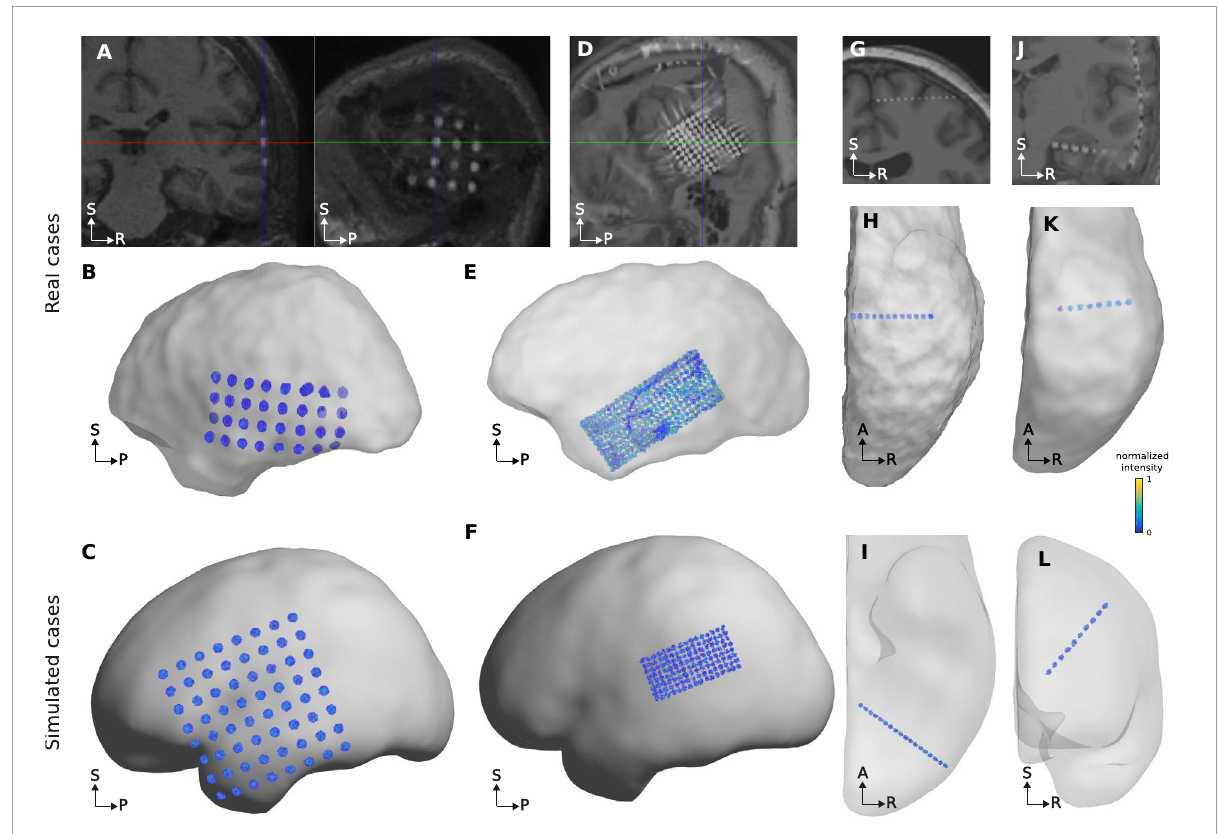
FIGURE6 Examples of real and simulated electrode CT artifacts. Images on the top row (A,D,G,J) show electrode artifacts on CT images superimposed on co-registered MRIs from real cases. Plots on the middle row (B,E,H,K) show thresholded CT voxels corresponding to electrodes in relation to the SCE surface for the same cases as above. Plots on the bottom row (C,F,I,L) show simulations similar to the real examples above. Observe the similarity between the real and simulated CT artifacts. The examples selected have different noise levels to reflect some of the variability observed. The real grid case in (A,B) , and the correspondingly simulated grid (C) have relatively low noise, whereas the real case depicted in (D,E) , and simulation (F) show a higher noise level. The case depicted in (E) also shows a cable passing over the grid. Both real and simulated depth electrodes depicted in (G–I) have low noise levels, whereas cases shown in (J–L) have medium noise levels. Array details: (A,B) 4 × 8 grid, 10 mm IED, implanted over the temporal cortex. (D,E) 10 × 25 grid, 3 mm IED, implanted over the temporal cortex. (G,H) 12 electrodes depth array, 3.5 mm IED, implanted into the superior frontal cortex. (J,K) 8 electrodes depth array, 5 mm IED, implanted into the temporal cortex. (C) 8 × 8 grid, 10 mm IED, over the fronto-temporo-parietal cortex. (F) 4 × 8 grid, 3 mm IED, over the temporo-parietal cortex. (I) 18 electrodes depth array, 3 mm IED, implanted into the occipital cortex. (L) 10 electrodes depth array, 5 mm IED, implanted into the frontal cortex. For illustration purposes, the SCE surfaces are semi-transparent. IED, inter-electrode distance; SCE, smooth cortical envelope. A, anterior; P, posterior; R, right; S,